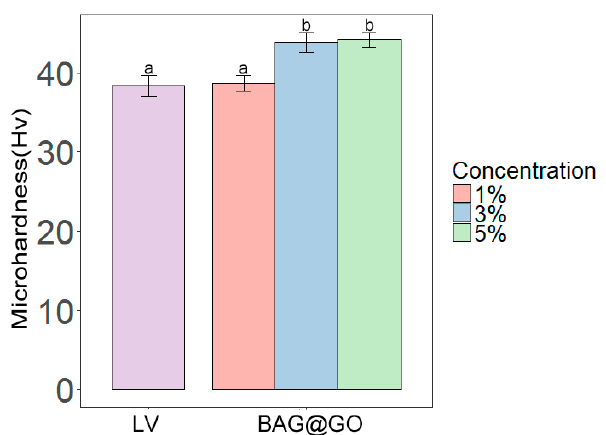
Figure 3. Microhardness comparison of orthodontic bonding adhesive containing LV and different weight percentages of BAG@GO. The same letters indicate no statistically significant difference between the groups ( p < 0.05) by Duncan’s multiple comparison test. Error bars are shown ± standard deviation.